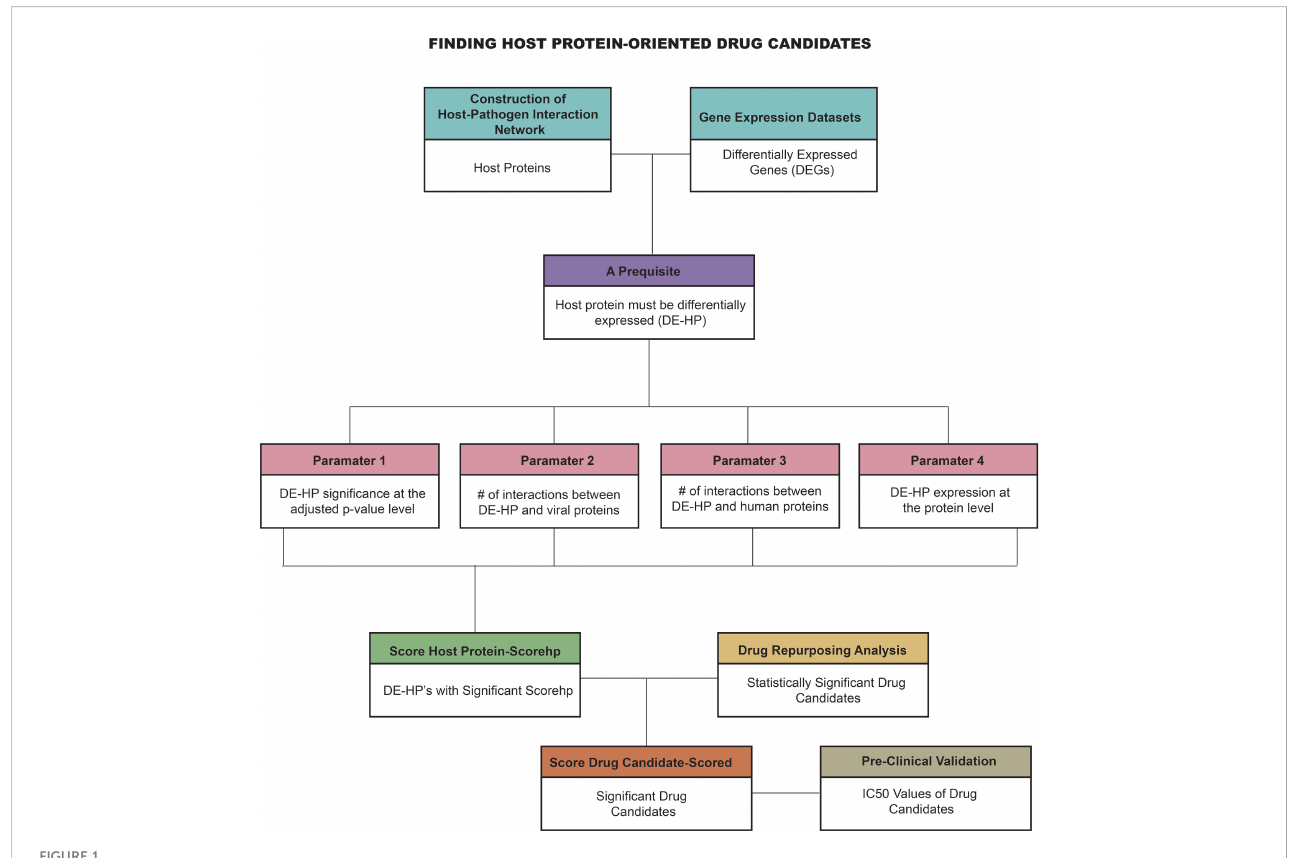
FIGURE 1 The novel computational framework employed in the study. (#,